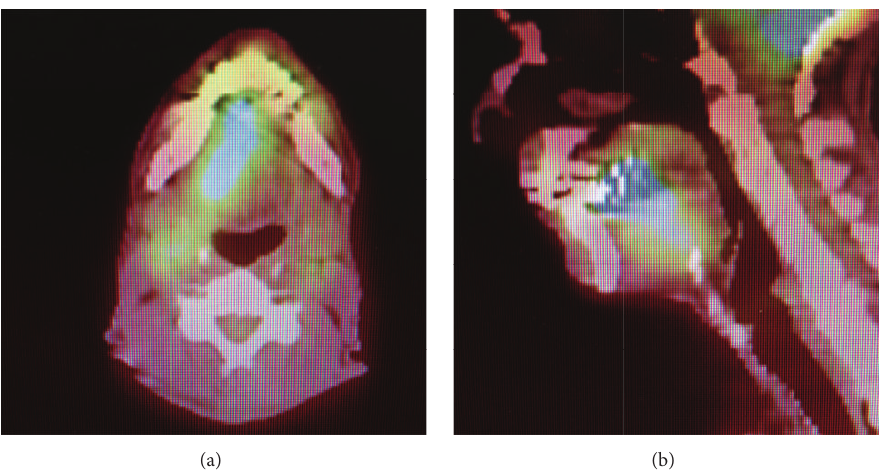
Figure 7: PET scan showing hypermetabolic activity in the tongue and